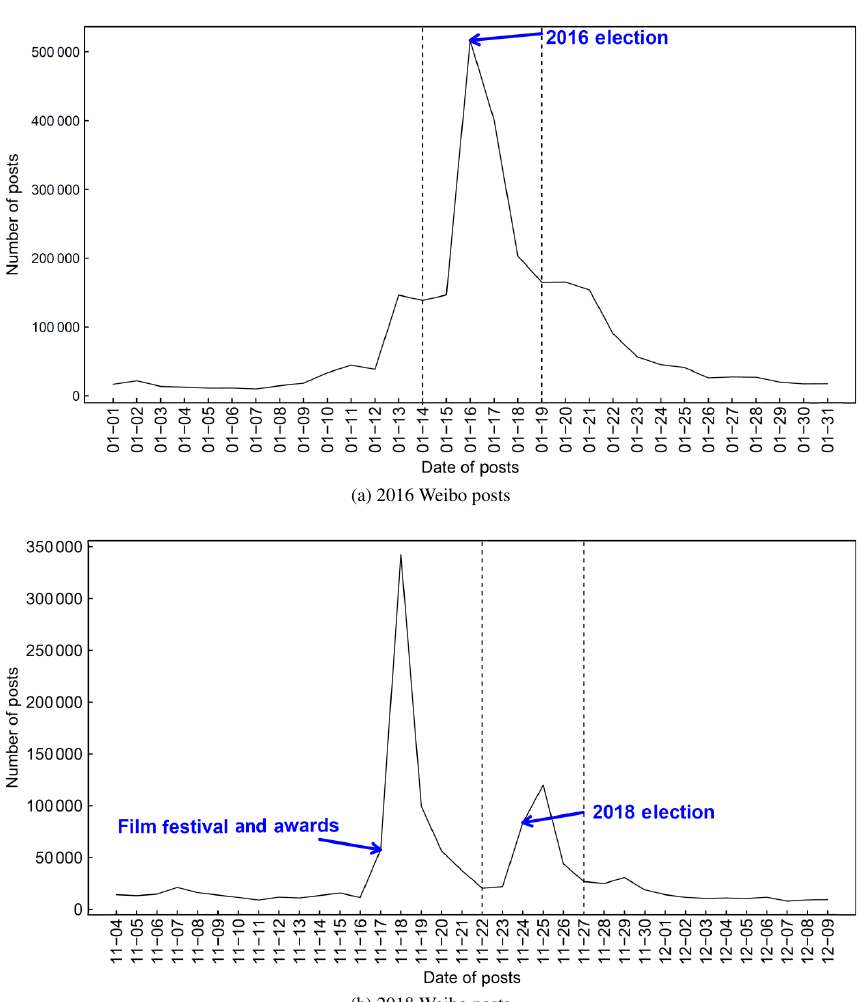
Fig. 1 Plot of the number of Weibo posts by date. Two spikes were observed near the election day in 2018. The first spike is about the Film Festival and Awards, which is an awards festival for Chinese language films. The second spike concerns the